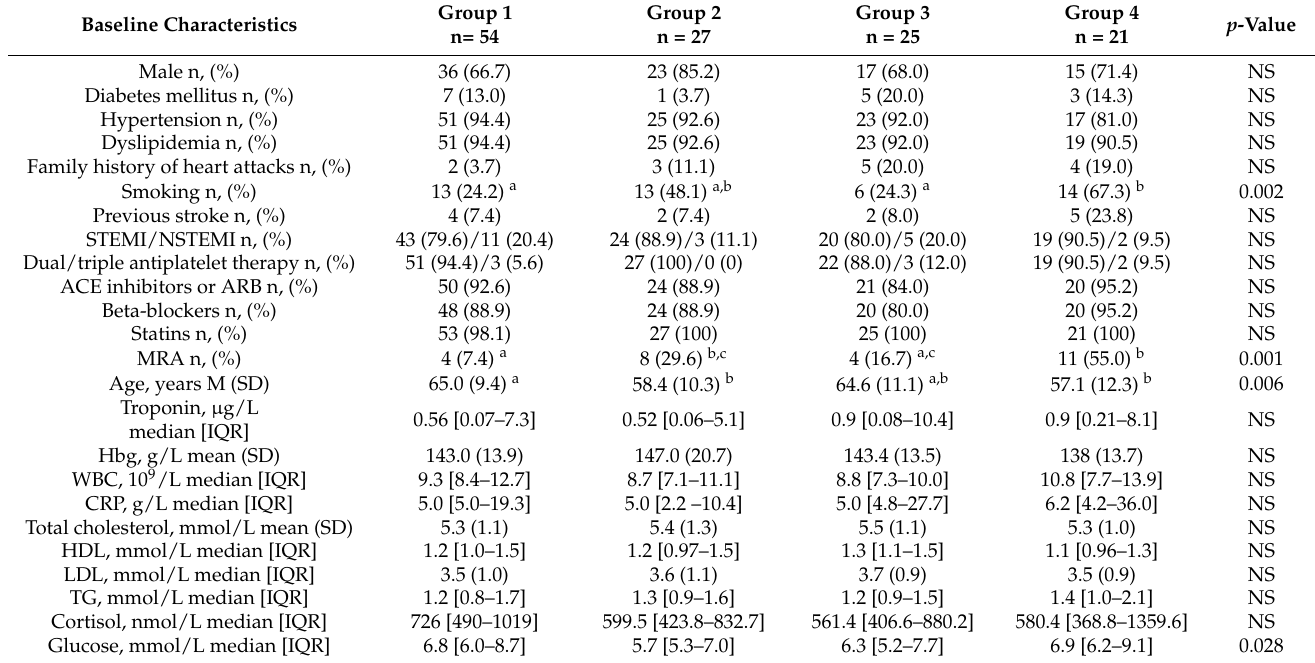
Table 1. Baseline characteristics of patients (n = 127) in the FLVR groups after AMI.